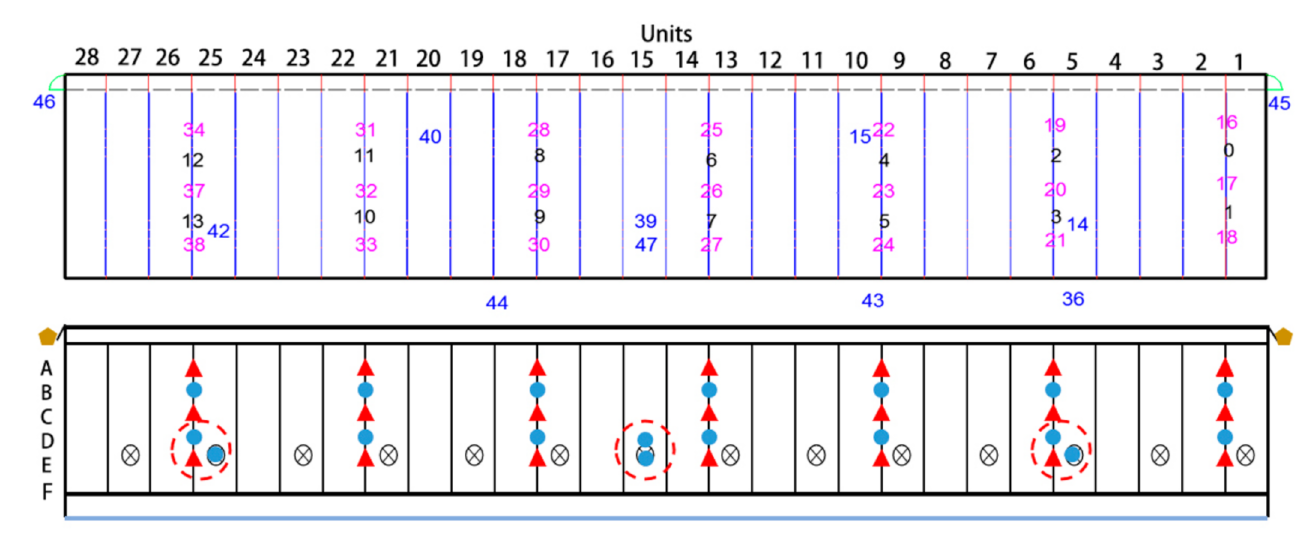
Figure 4. Views of the node distribution of the pig house. Note: 0 to 47 are the nodes IDs; a triangle represents a node arranged at a height of 60 cm, a circle represents a node arranged at a height of 150 cm, a pentagon represents a node arranged at a height of 190 cm outside the building, and the red dotted circle indicates that it is located under the fan; A–F are the rows.